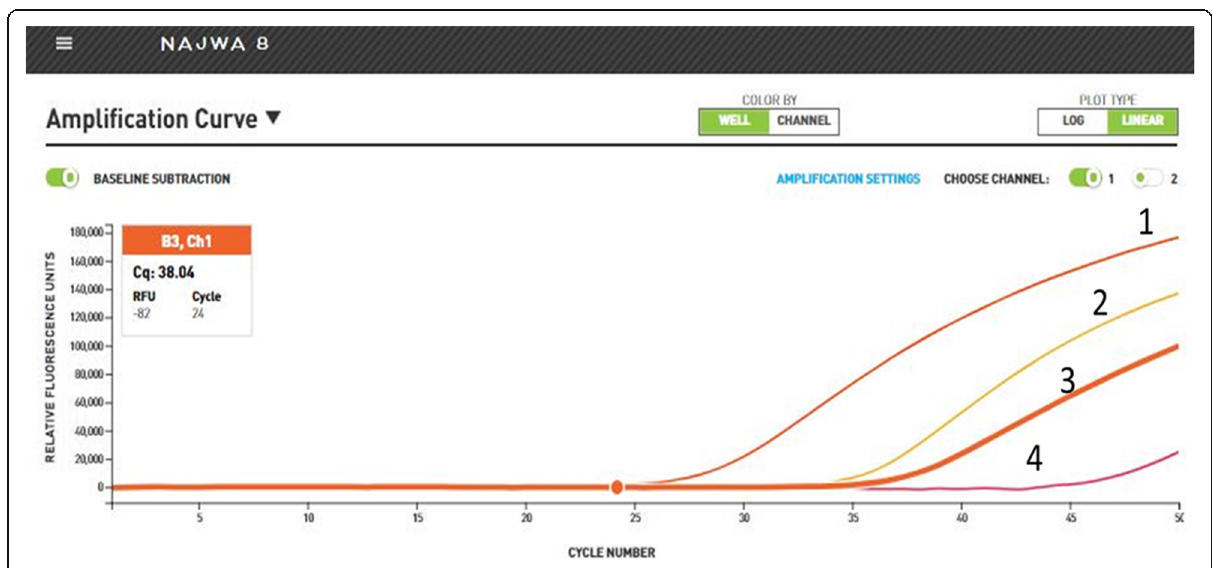
Fig. 1 The fluorescent Ct curve for Kt (1 = M28, 2 = M1, 3 = M2, and 4 = ACT) genes for Torulaspora delbrueckii